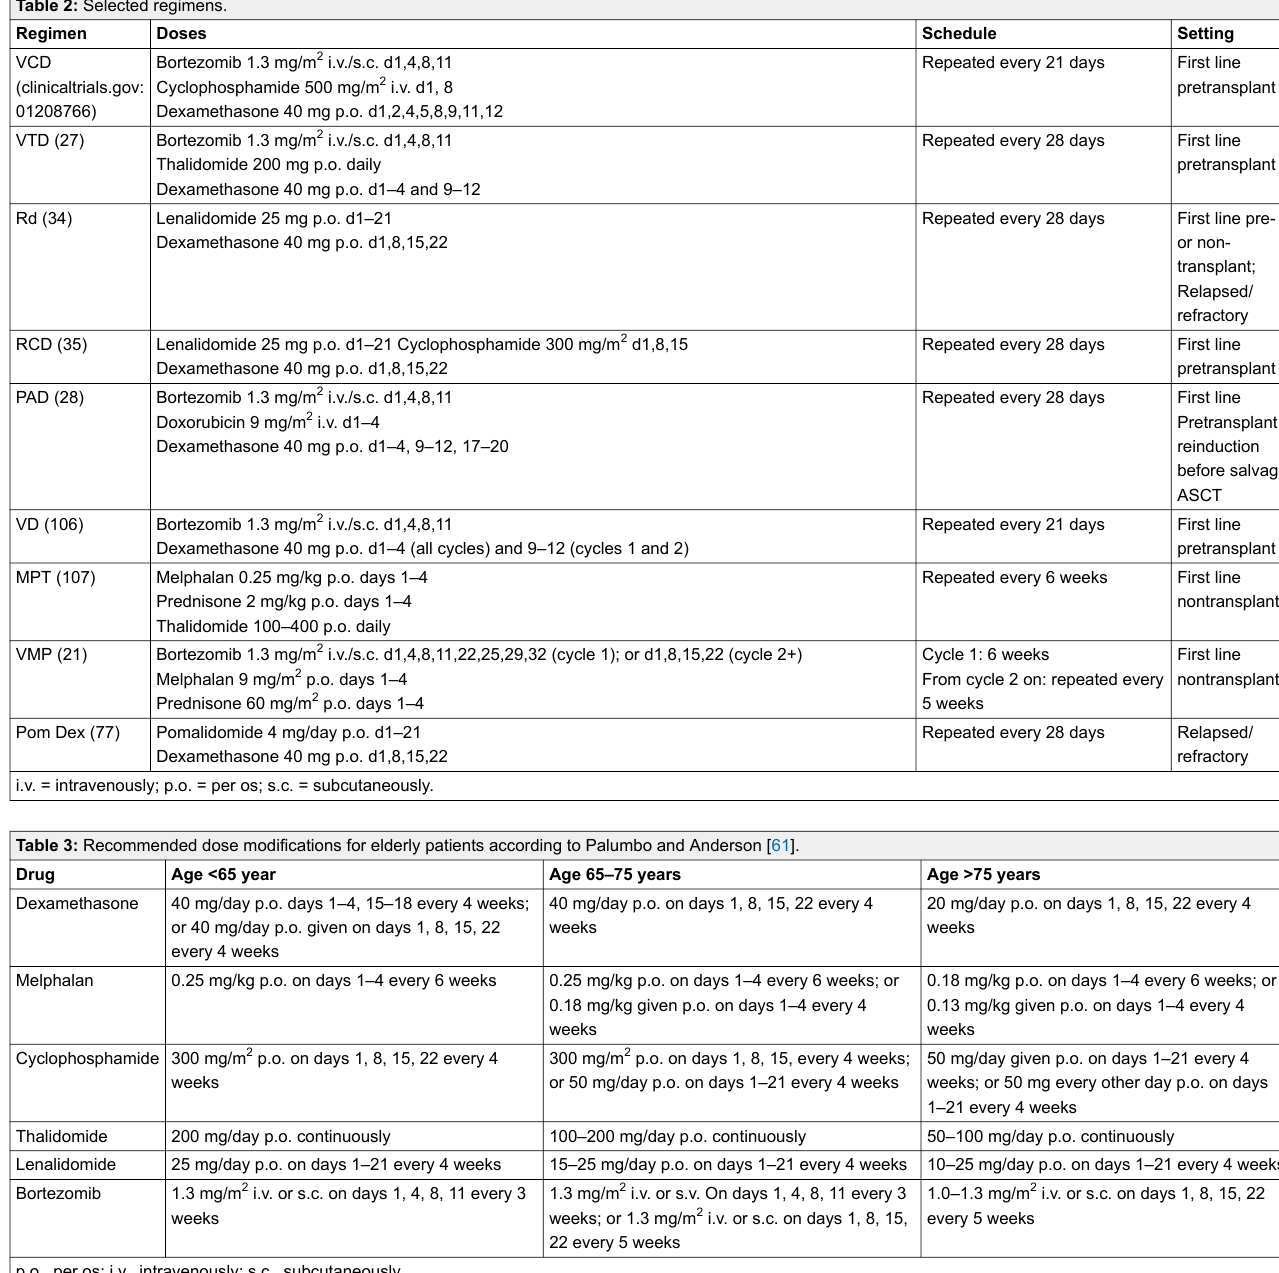
Repeated every 28 days First line pre-